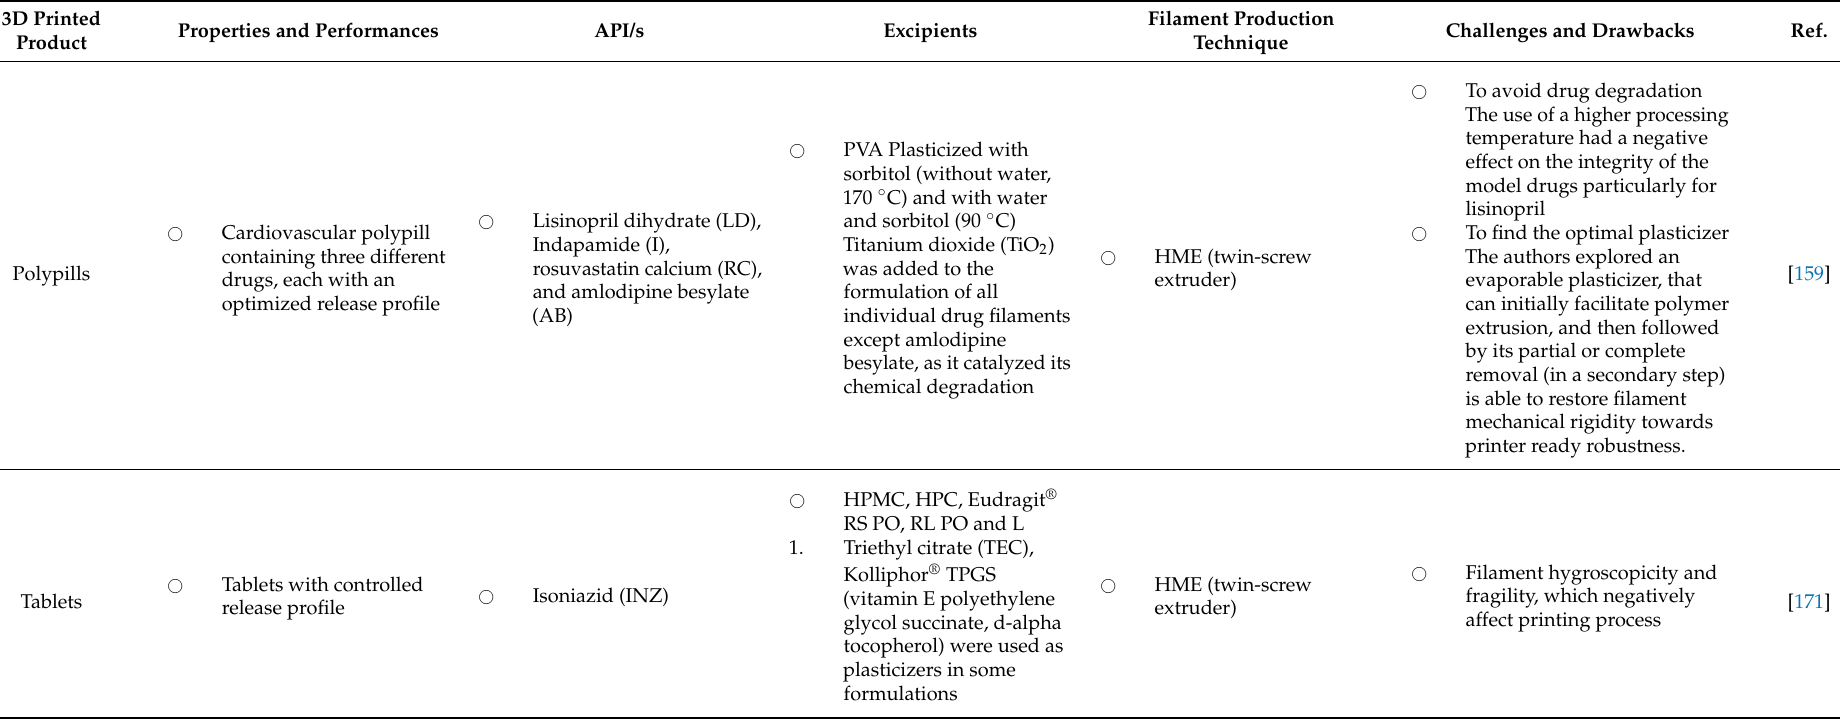
Table 2. Literature examples on dosage forms and medical devices produced via FFF 3DP. In evidence for each product—performances; —starting materials (polymers/excipients and APIs); —drug loading strategy; —challenges and